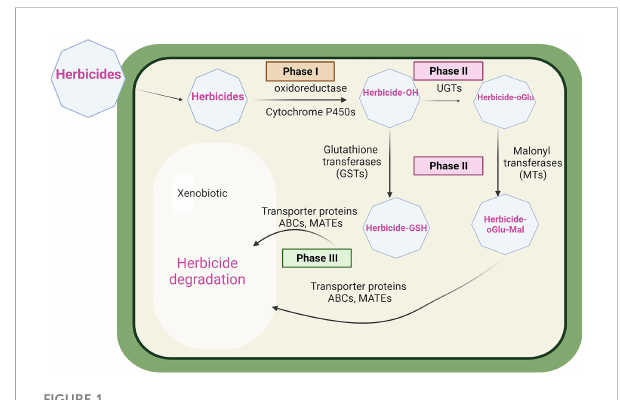
FIGURE 1 Herbicide detoxi fi cation in plants. In phase 1, herbicides are typically metabolized by cytochrome P450 monooxygenase enzymes prior to phase 2 bioconjugation with glutathione or sugars catalysed by glutathione transferase (GSTs), or UDP-glycosyl dependent transferases (UGTs) malonyl transferases (MTs). In phase 3, conjugated metabolites are then transported into the vacuole by ABC, or MATE transporters, pending further